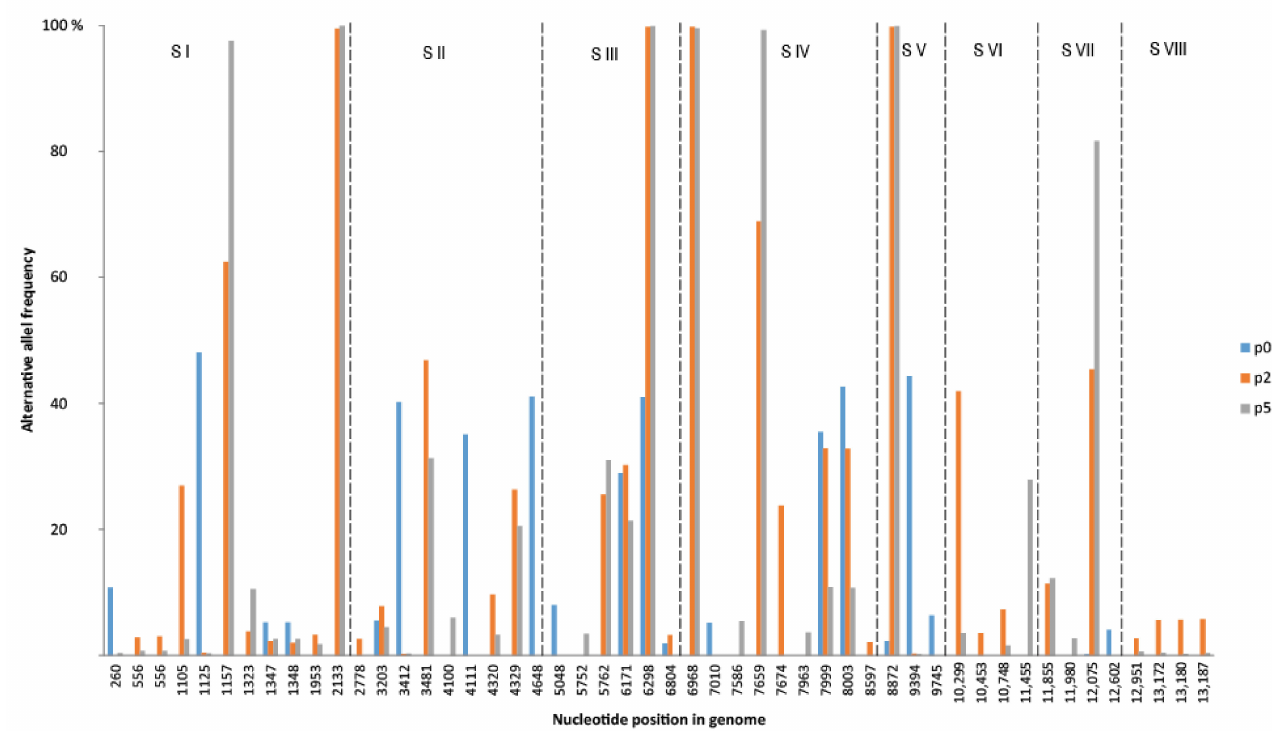
Figure 1. The frequency and distribution of single nucleotide variants of the A/equine/Pulawy/2005 detected in nasal swabs (passage 0) and passages in embryonated chicken eggs (passage 2 and passage 5). S I–S VIII genome